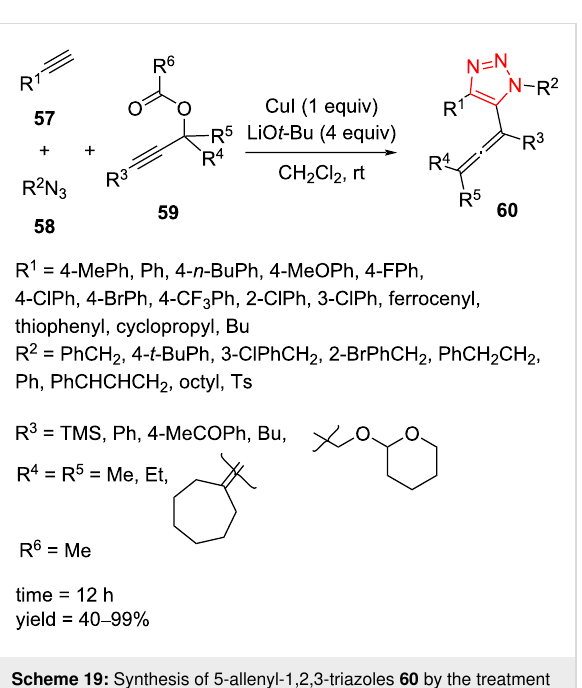
Scheme 19: Synthesis of 5-allenyl-1,2,3-triazoles 60 by the treatment of alkynes 57 , azides 58 , and propargylic carbonates 59